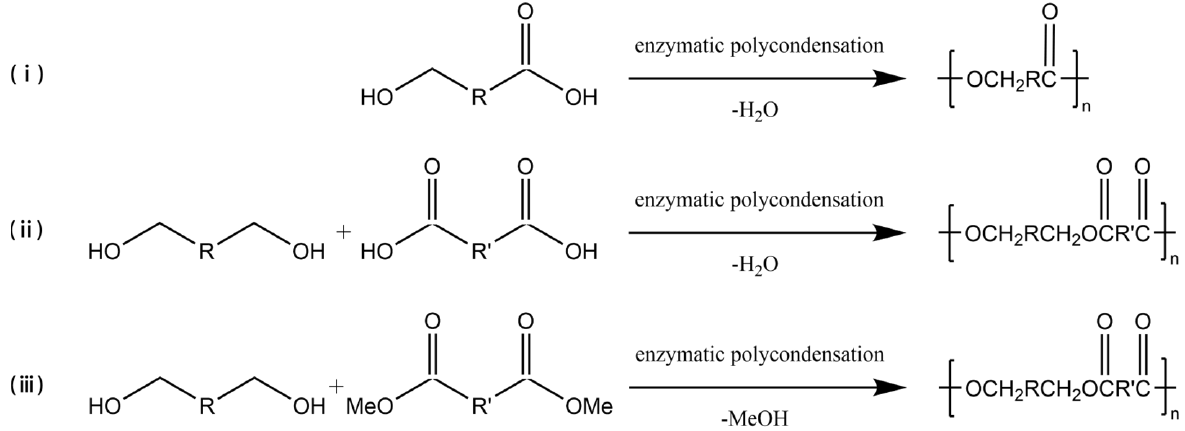
Figure 2. The enzyme-catalyzed polycondensation of ( ⅰ ) hydroxyacids, ( ⅱ ) diols and diacids, and ( ⅲ ) diols and diacid derivatives.